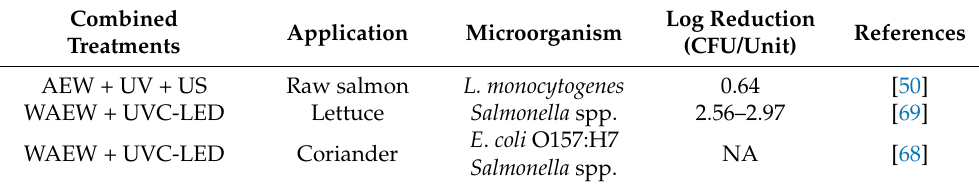
Table 6. Combinations of AEW and WAEW with UVC-LED.